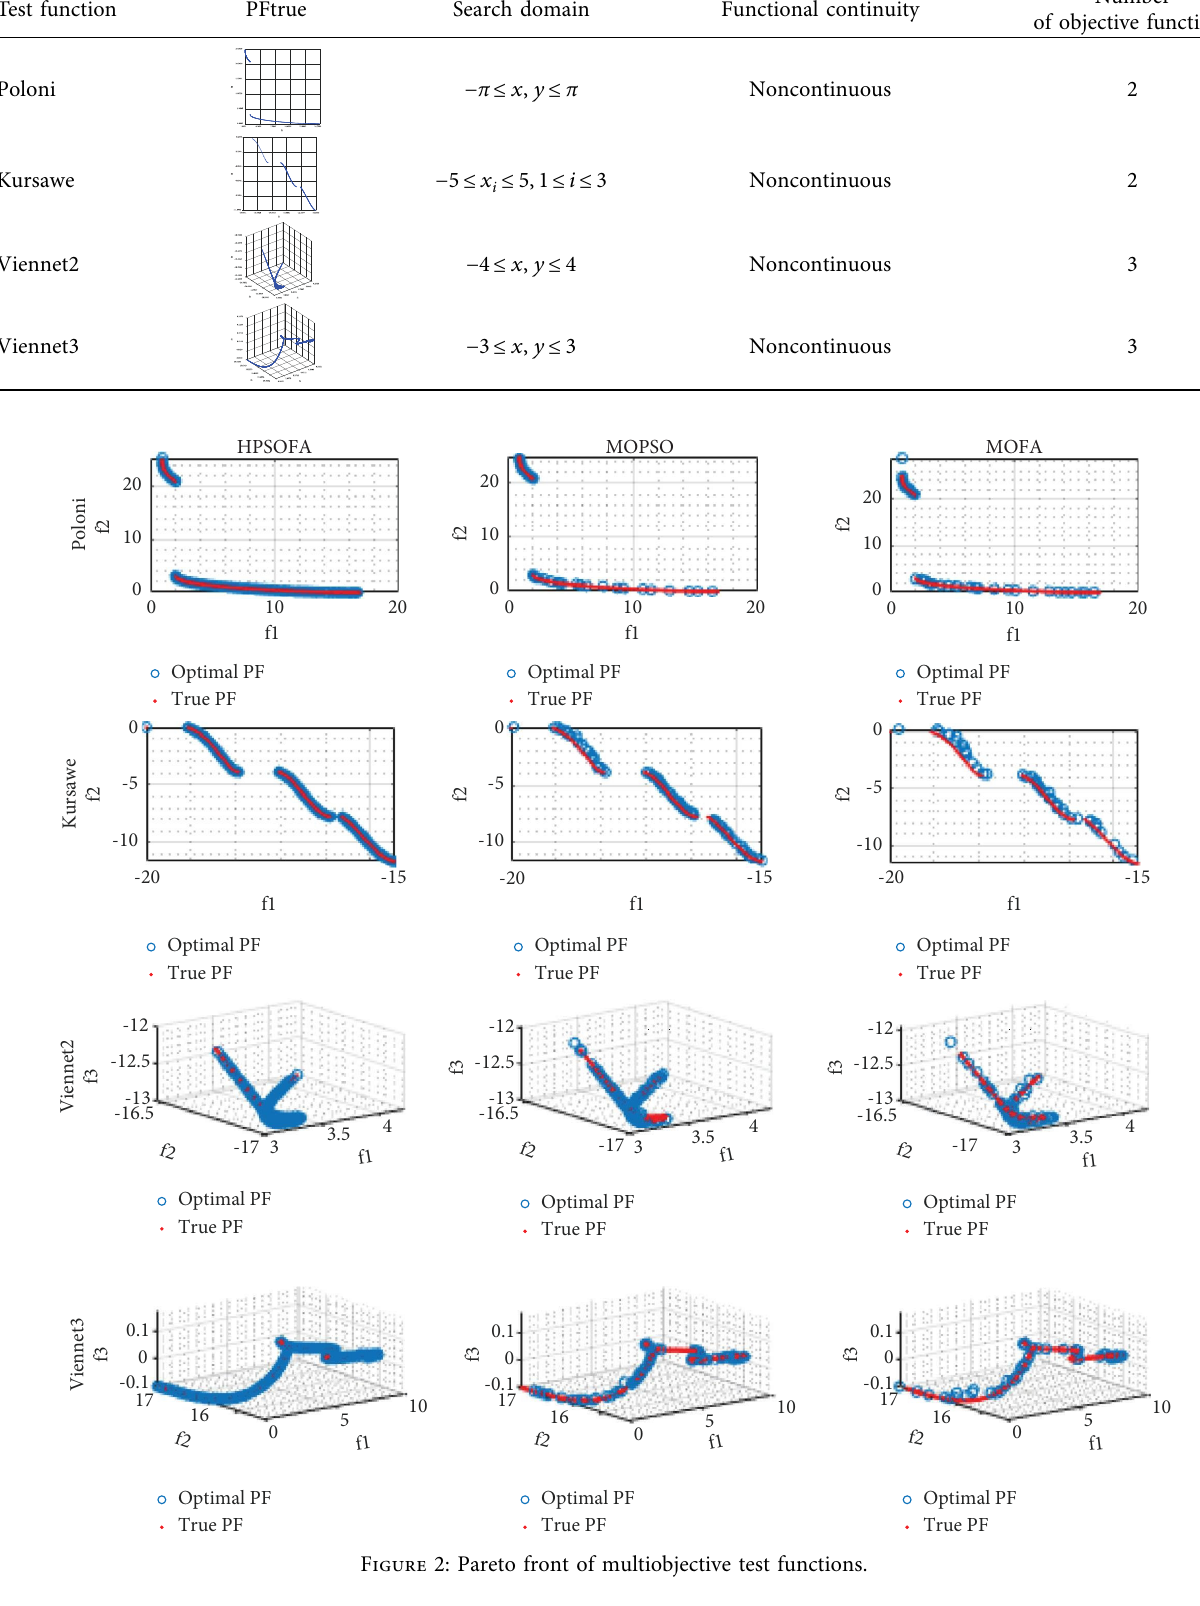
Figure 2: Pareto front of multiobjective test